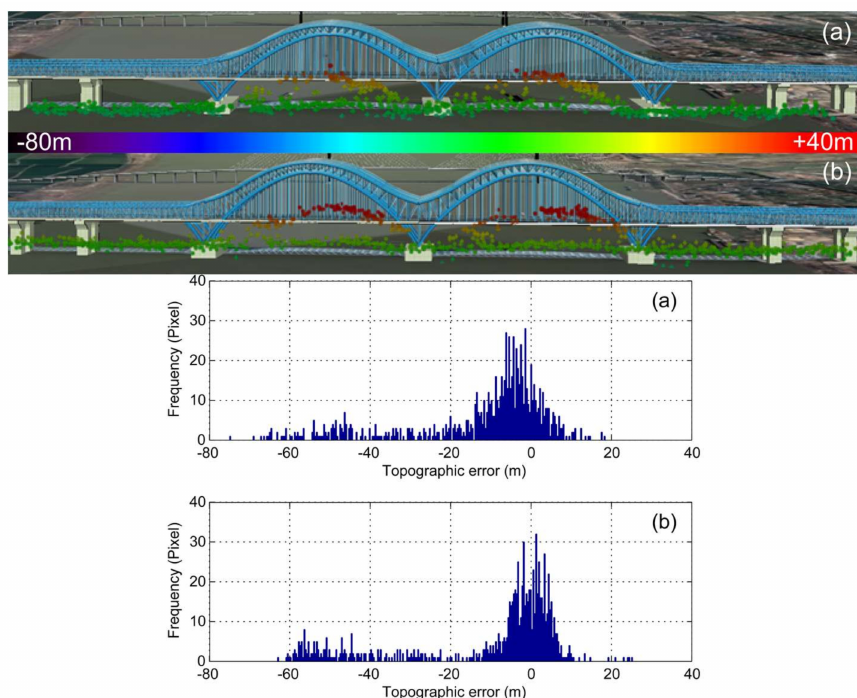
Figure 7. Estimated topographic errors and their statistics for the NDHRB. The figure marked with ‘( a )’ is related to Track 01, and that with ‘( b )’ refers to Track 02.